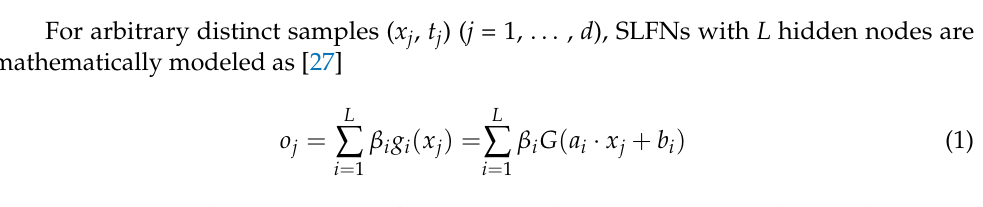
Figure 4. Single-hidden layer feedforward network.